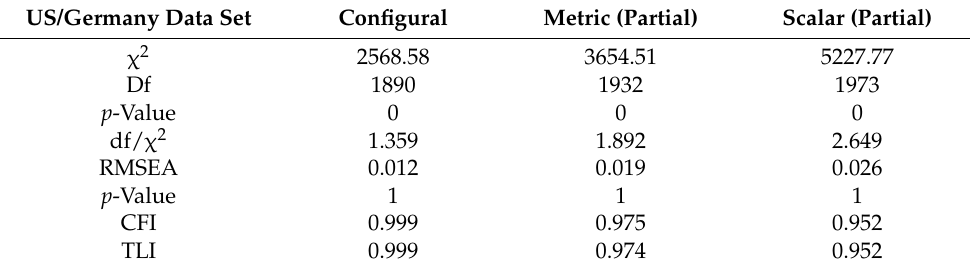
Table 3. Results of the Measurement Invariance Analyses.